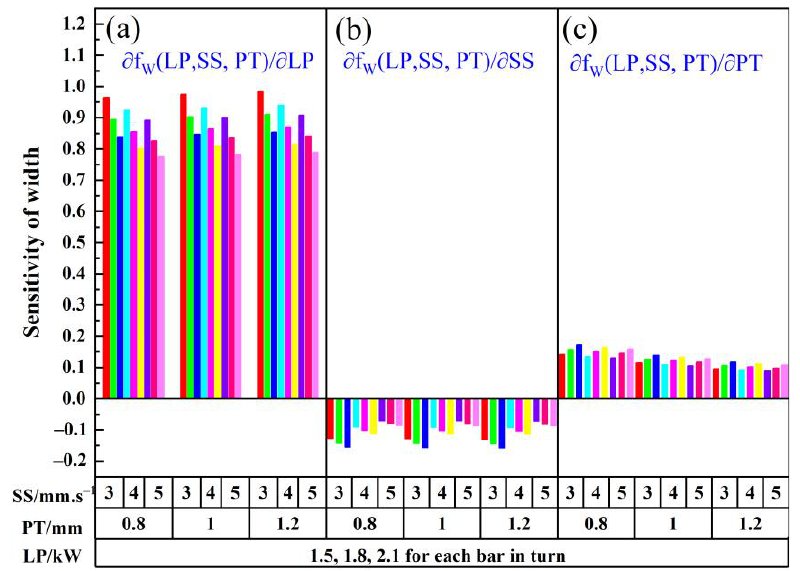
Figure 7. Sensitivity of width to cladding parameters. ( a ) laser power; ( b ) scanning speed; ( c ) powder thickness.